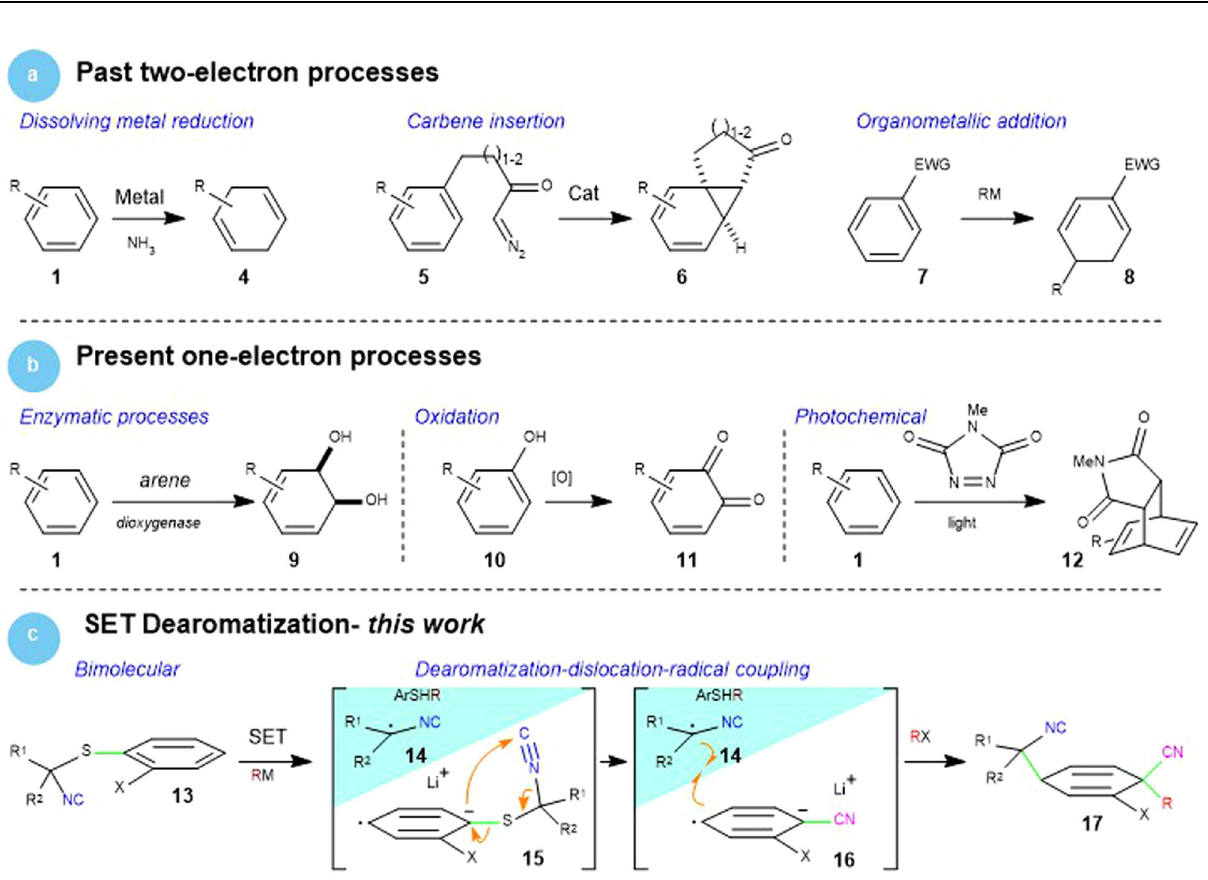
Fig. 2 | Dearomatization methods: past and present. a Classical dearomatization strategies employing two-electron reductions. b Current dearomatization processes employing one-electron processes. c This SET approach to dearomatization is followed by NC dislocation and radical – radical anion